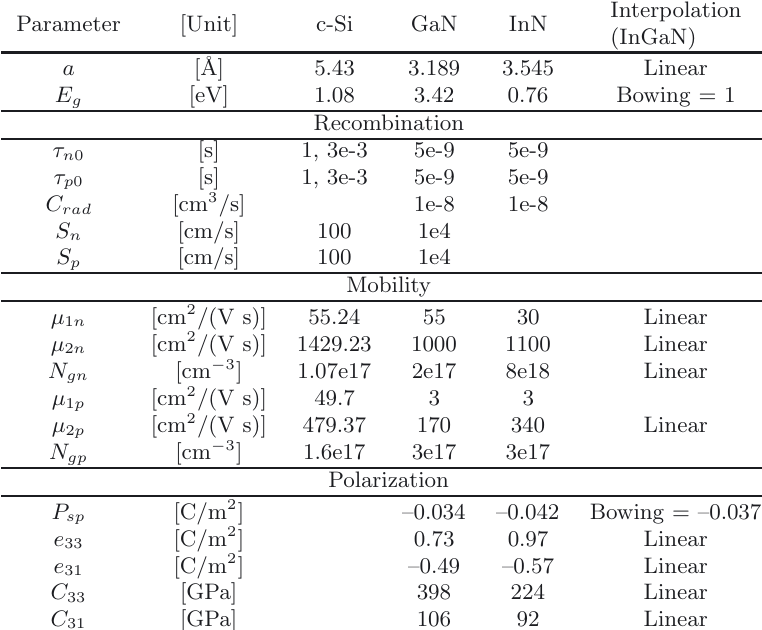
Table 1. Parameters used in